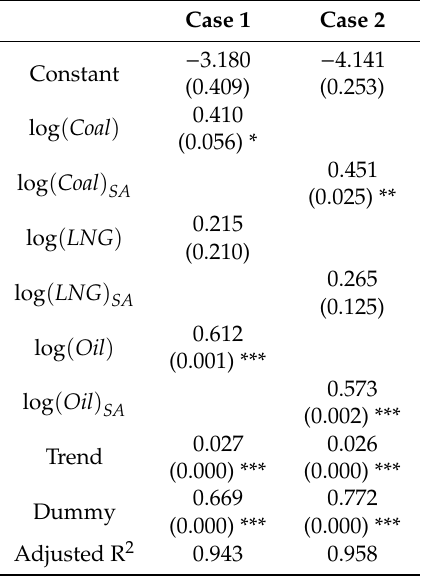
Table 5. Cointegrating regression (fully-modified OLS) for carbon emissions. Case 1: Seasonally unadjusted data. Case 2: Seasonally adjusted data. Case